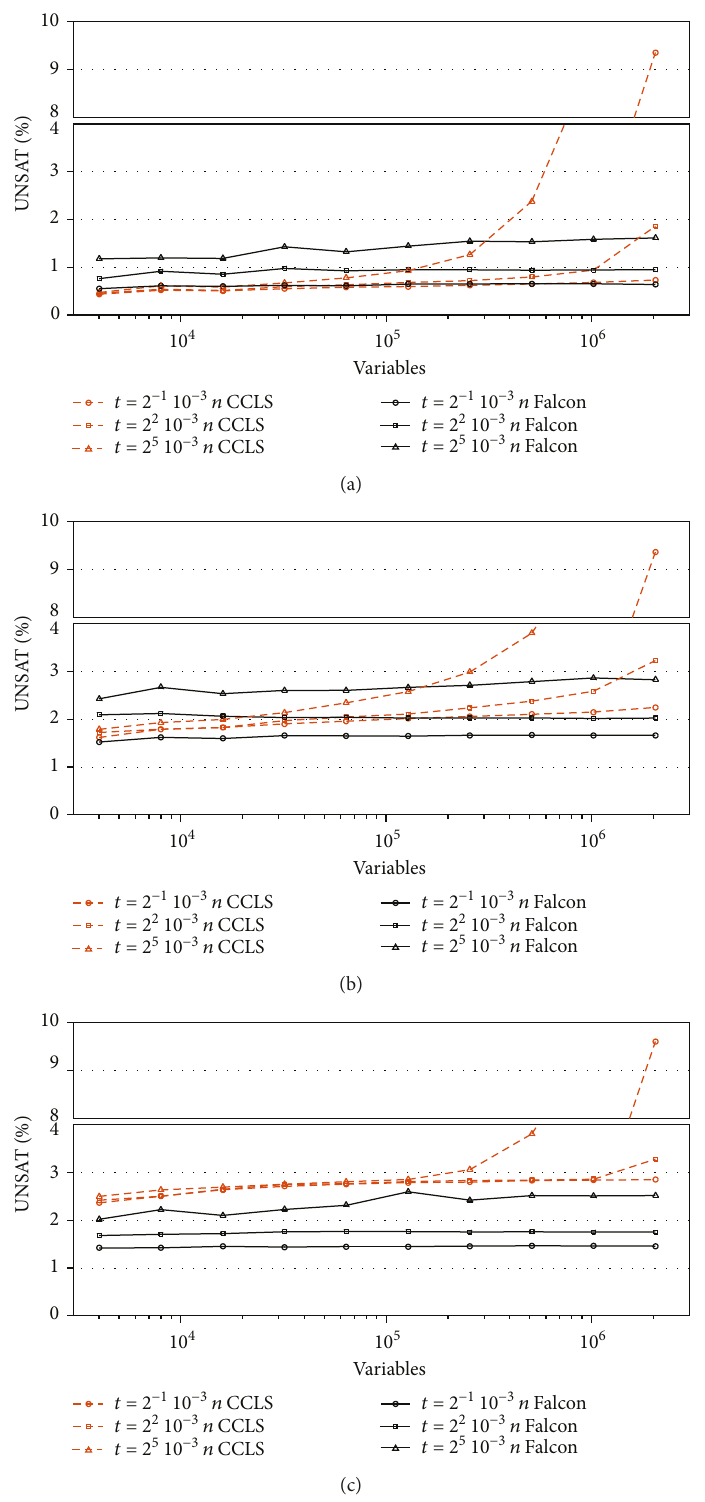
Figure 4: Comparison between the CCLS solver versus our solver, Falcon, for (a) random-Max-E3SAT, (b) hyper-Max-E3SAT, and (c) delta- Max-E3SAT. In these plots, the percentage of unsatis fi ed clauses versus the number of variables is shown. Di ff erent curves are for di ff erent simulation time-outs (in seconds) following the relation t = kn with n = ∣ x ∣ and k an integer given in the legend. All calculations have out been performed on a single thread of an Intel Xeon E5-2680 v3 with 128 Gb DRAM shared on 24